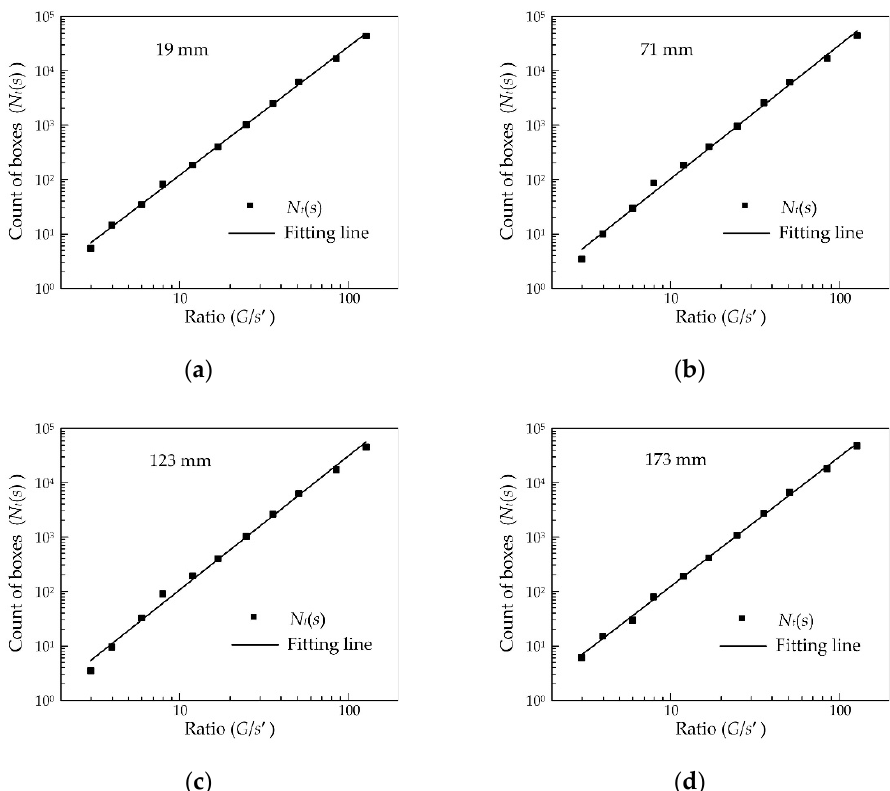
Figure 8. Fitting results of tracking according to IDBCM with particle at various locations. In ( a ), the particle is located at 19 mm. In ( b ), the particle is located at 71 mm. In ( c ), the particle is located at 123 mm. And in ( d ), the particle is located at 175 mm.